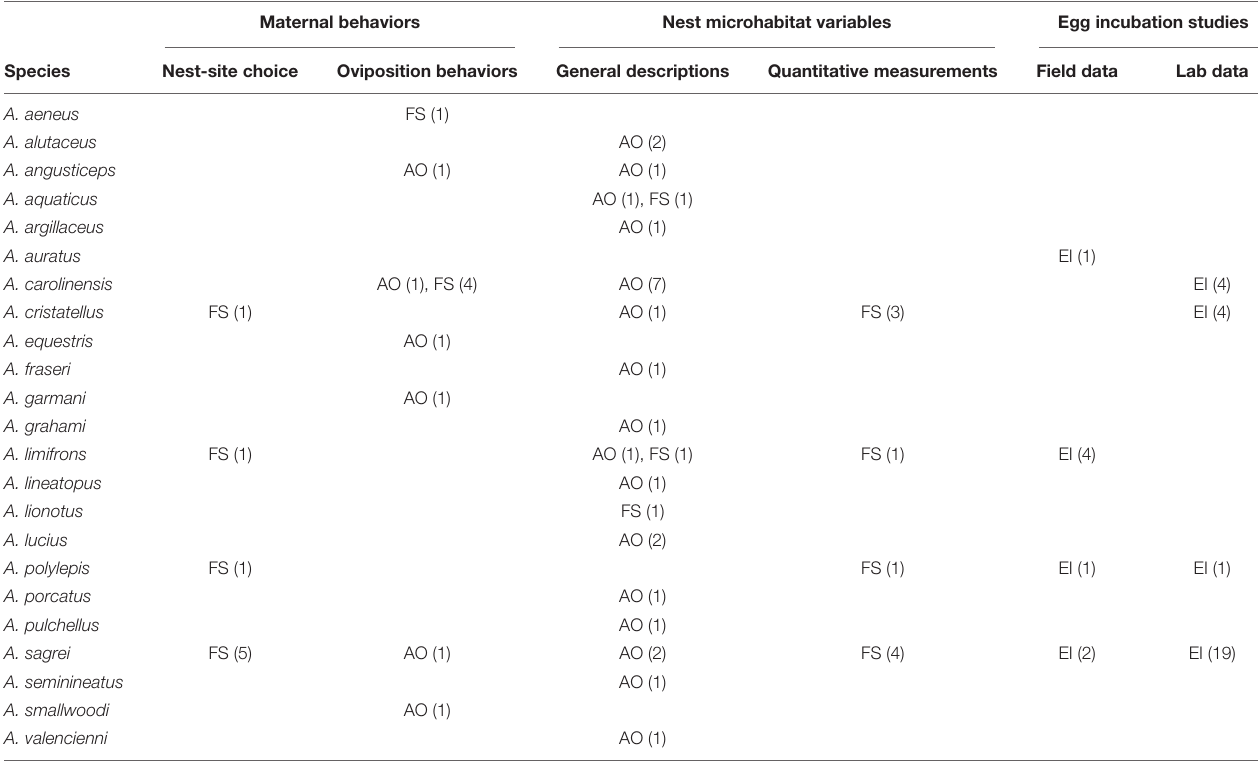
TABLE 1 | Summary of studies that provide information on nesting ecology for different Anolis species. Maternal behaviors Nest microhabitat